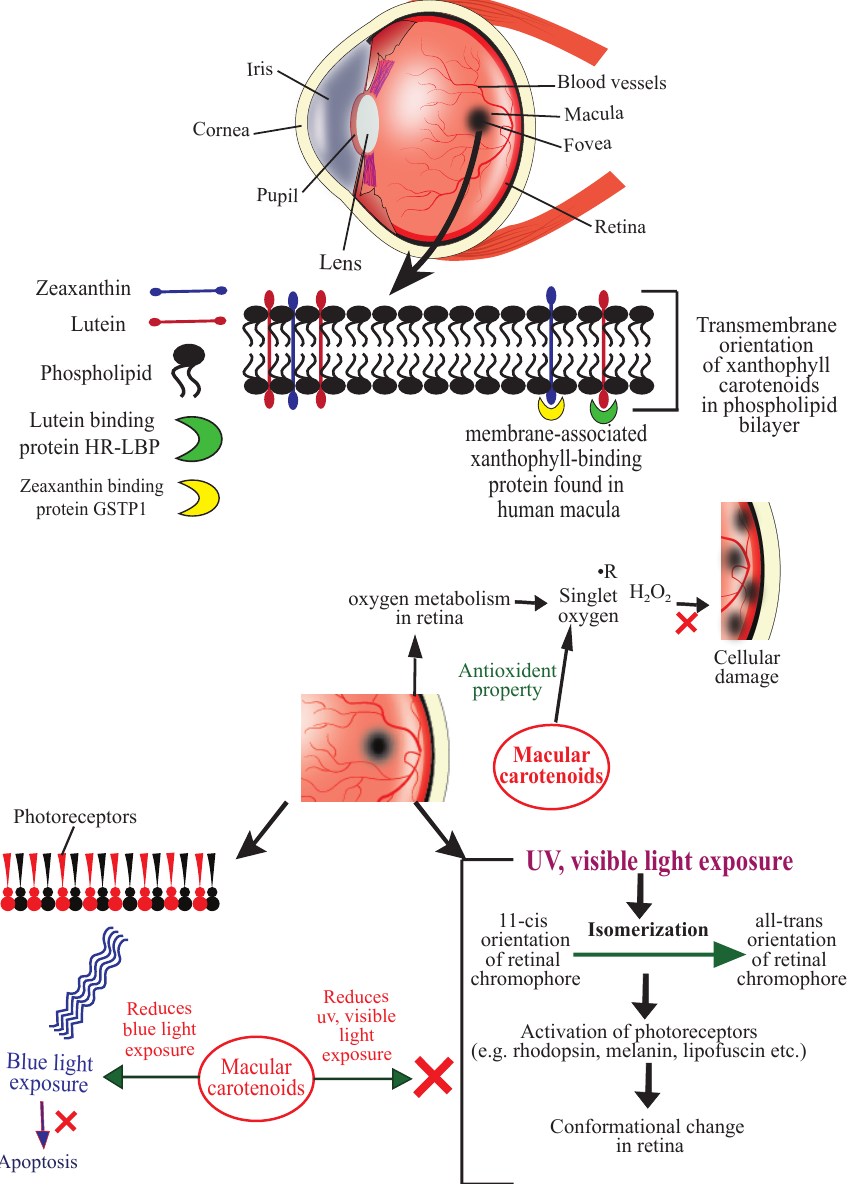
Figure 1. Schematic diagram showing the mechanisms of action of carotenoids to prevent age-related macular degeneration (AMD). HR-LBP: human retinal lutein-binding protein; GSTP1: glutathione S-transferase Pi 1; R: free radical (symbolic